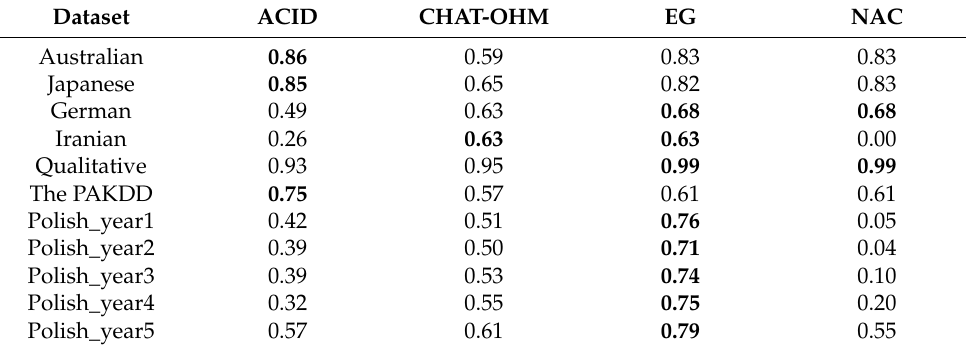
Table 7. Geometric mean of the compared classifiers. The best results are indicated in bold.